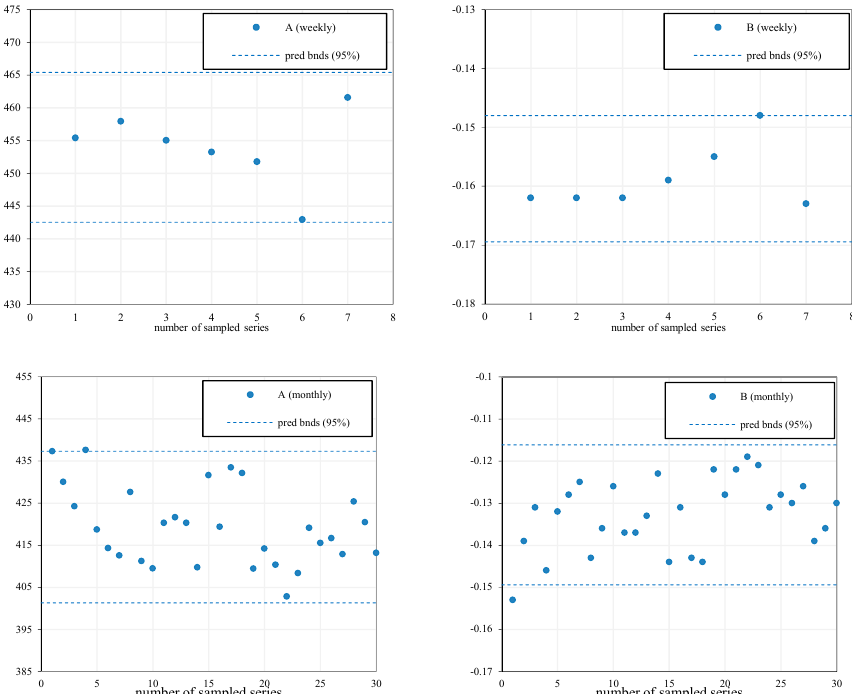
Figure 6. 95% prediction boundaries (pred bnds) for the regression model parameters A and B in Equation (6) for the case of discontinuous measurements. The upper panel refers to a weekly monitoring program, and the lower panel refers to a monthly monitoring program.